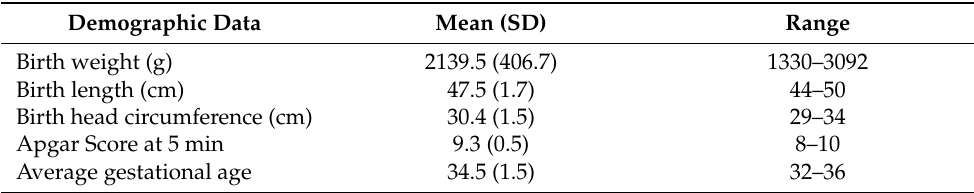
Table 1. Demographic data of participants ( n = 33).